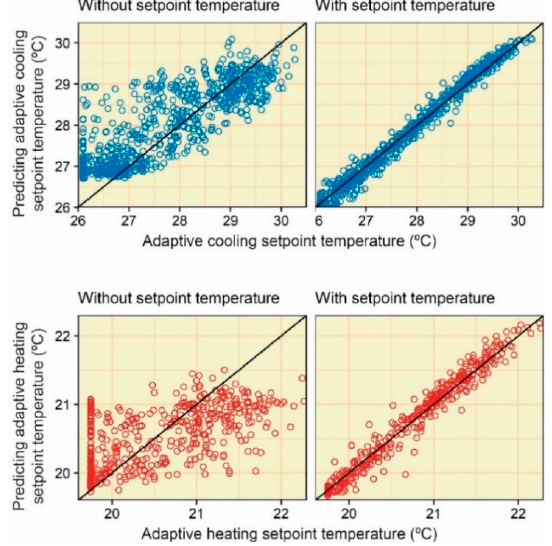
Figure 7. Influence of applying the setpoint temperature from the previous day on the MLP by using the external temperature of the weather station of Xesteiras. Table 7. Results of the training and testing of the MLR models of approach 1.